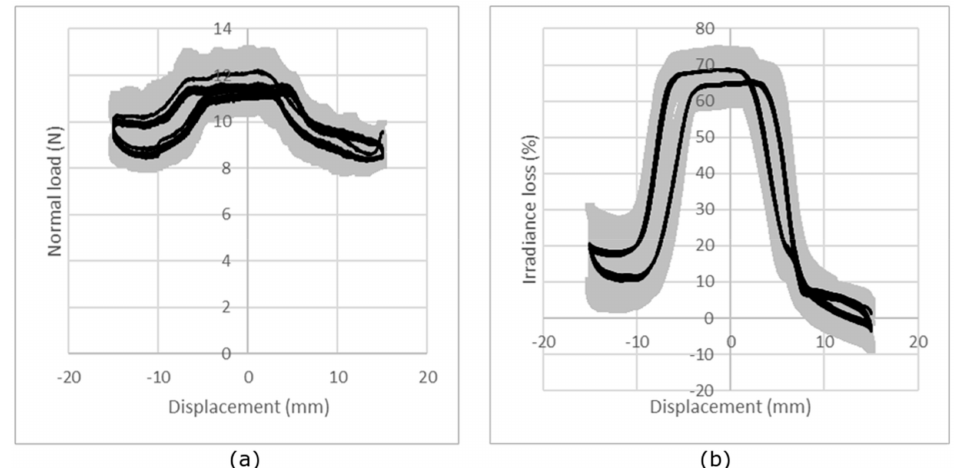
Figure 11. Reproducibility of measurements: ( a ) evolution of the normal force and ( b ) evolution of the loss of irradiance relative to the displacement of the slider for five samples of single jersey under a nominal load of 10 N. The black line represents the average curve and the gray area the standard